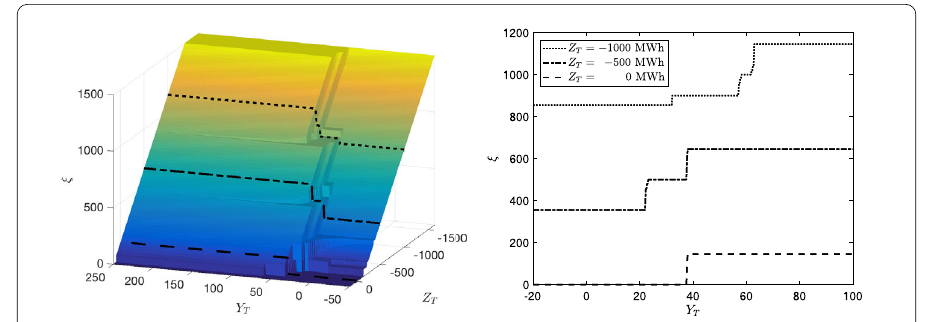
Figure 6 Optimal conventional generation ξ as a function of Y T and Z T (left) as well as for some values of Z T (right; the lines correspond to those on the left graph)